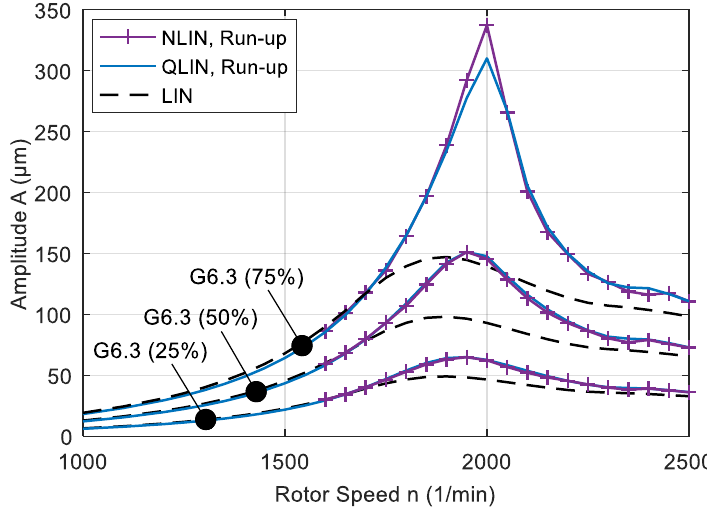
Figure 16. Absolute NDE bearing amplitudes for the 4-tilting-pad bearing for three different unbal- ances and analysis types.